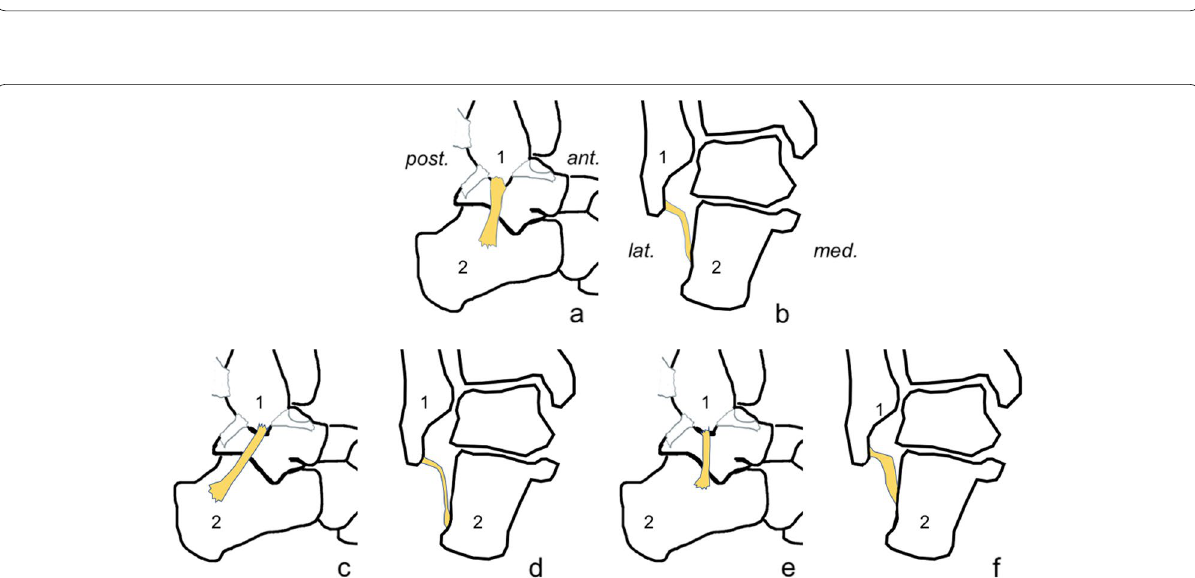
Fig. 8 Examples of correlations between the dimensions of the calcaneofibular ligament. A , c , and e lateral view; b , d , and f coronal section. Ant., anterior; post., posterior; med., medial; lat., lateral. C and d the increased length is negatively correlated with the width, thickness, and length of the fibular attachment and the CFL angle. E and f the increased thickness is positively correlated with the CFL angle and negatively correlated with the length of the fibular insertion and the width and length of the whole ligament, and there is a very weak negative correlation with length of the calcaneal